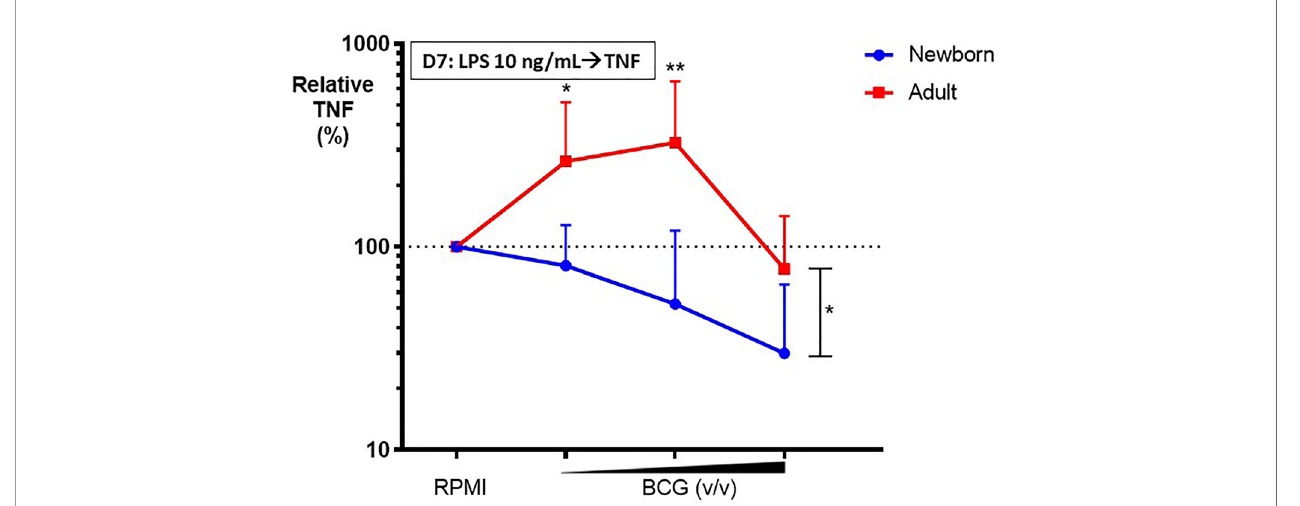
FIGURE 4 | BCG-training induces enhanced LPS-induced TNF responses in adult monocytes but diminished TNF responses in newborn monocytes. Human newborn and adult CD33+ monocytes were trained with BCG as described in Figure 1 . At Day 7 of culture, monocytes were stimulated by LPS prior to collection of supernatants for TNF ELISA. Relative TNF is the calculated ratio of trained vs. untrained TNF concentrations. N = 7 newborns, 9 adults. D, Day; v/v, volumetric concentrations. Bars indicate mean + SD. Repeated-measures 1-way ANOVA was used for comparisons across BCG concentrations and 2-way ANOVA was used for comparisons between age groups. *p < 0.05; **p < 0.01